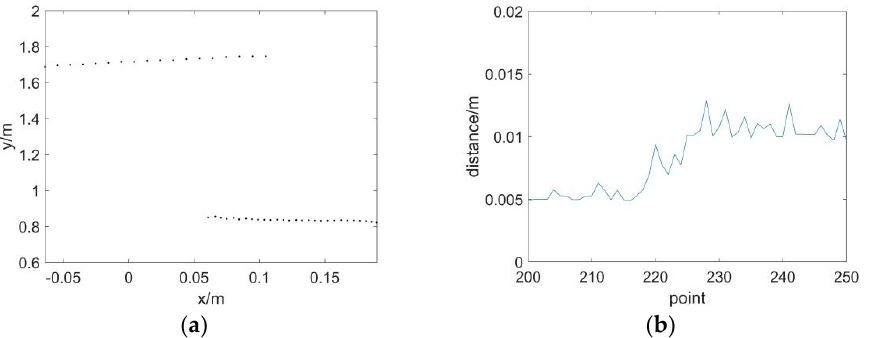
Figure 3. Breakpoint feature: ( a ) Lidar data points; ( b ) distance between adjacent points. Therefore, the selected breakpoint detection threshold D should be adaptively changed according to the distance measured by the laser, as shown in formula (6).